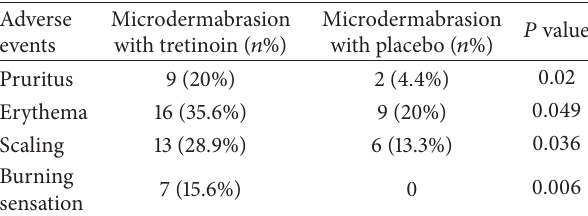
Table 5: Frequent adverse events reported in the study following treatment in intervention or control conditions.